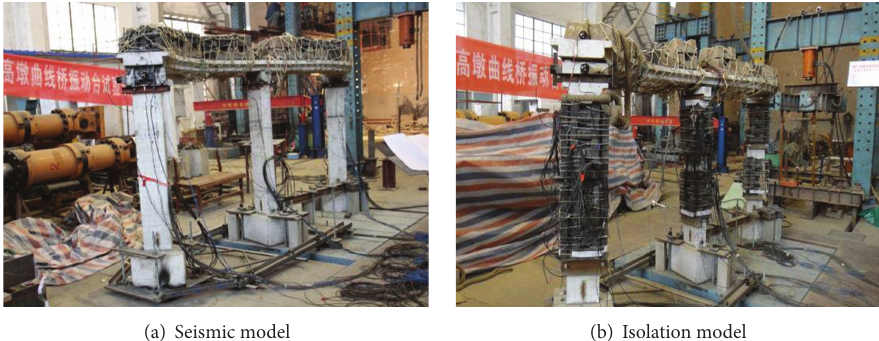
Figure 4: Reinforcement assembly of section (unit: cm).